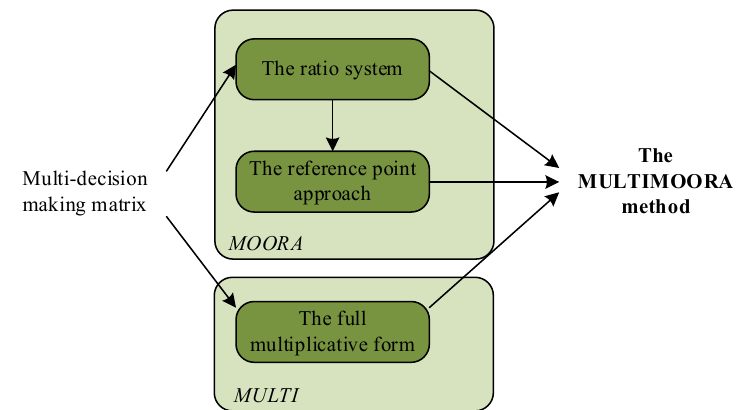
Fig. 2. Steps of MULTIMOORA method